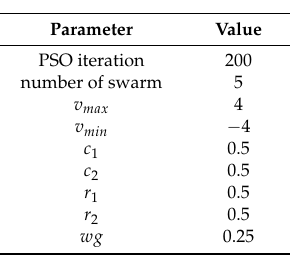
Table 4. Parameters for particle swarm optimization